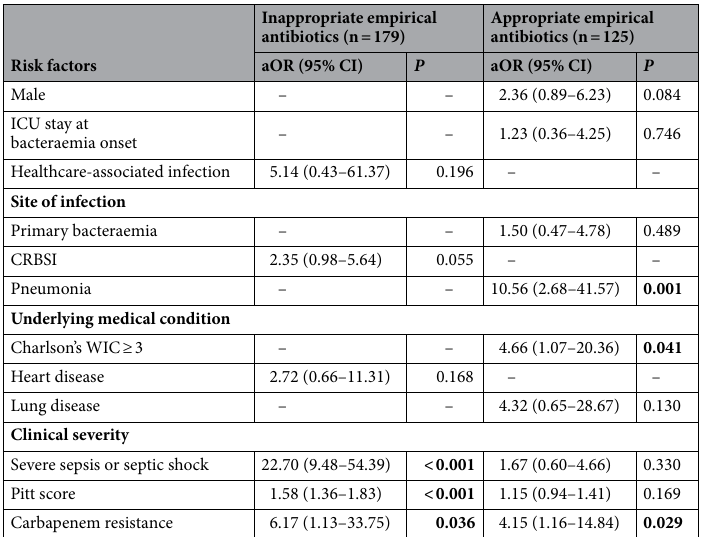
Table 3. Multivariate analysis of risk factors for treatment failure in patients with Acinetobacter baumannii bacteraemia, according to the appropriateness of empirical therapy. aOR, adjusted odds ratio; CI, confidence interval; ICU, intensive care unit; CRBSI, catheter related bloodstream infection; WIC, weighted index of comorbidity; –, the variable was not included in the multivariate analysis model, because it was not significant in univariate analysis ( P > 0.10). Significant values are in [bold].